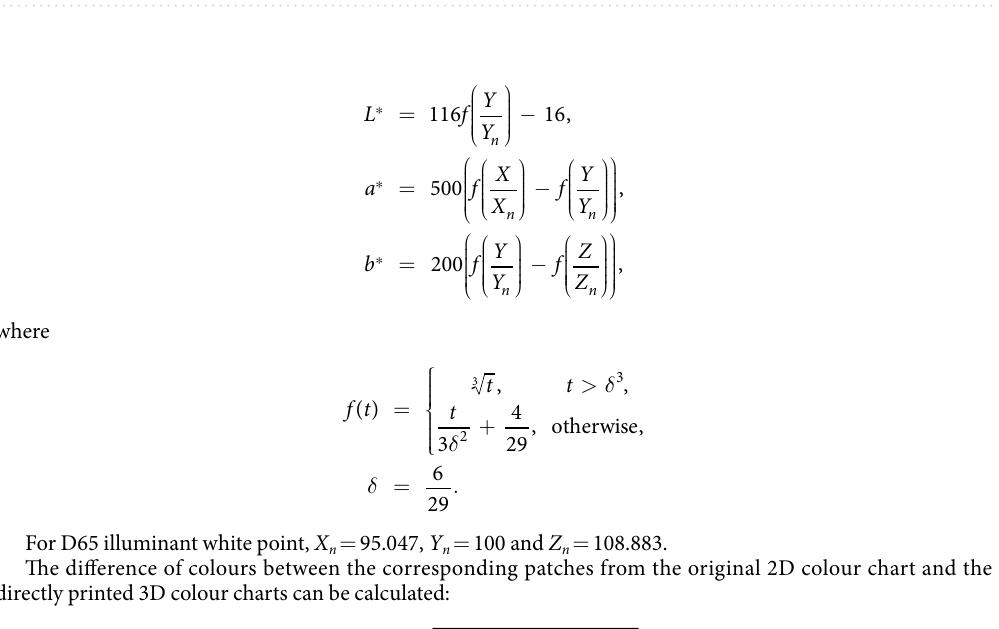
Table 1. Adjusted R-squares of different channels of colour